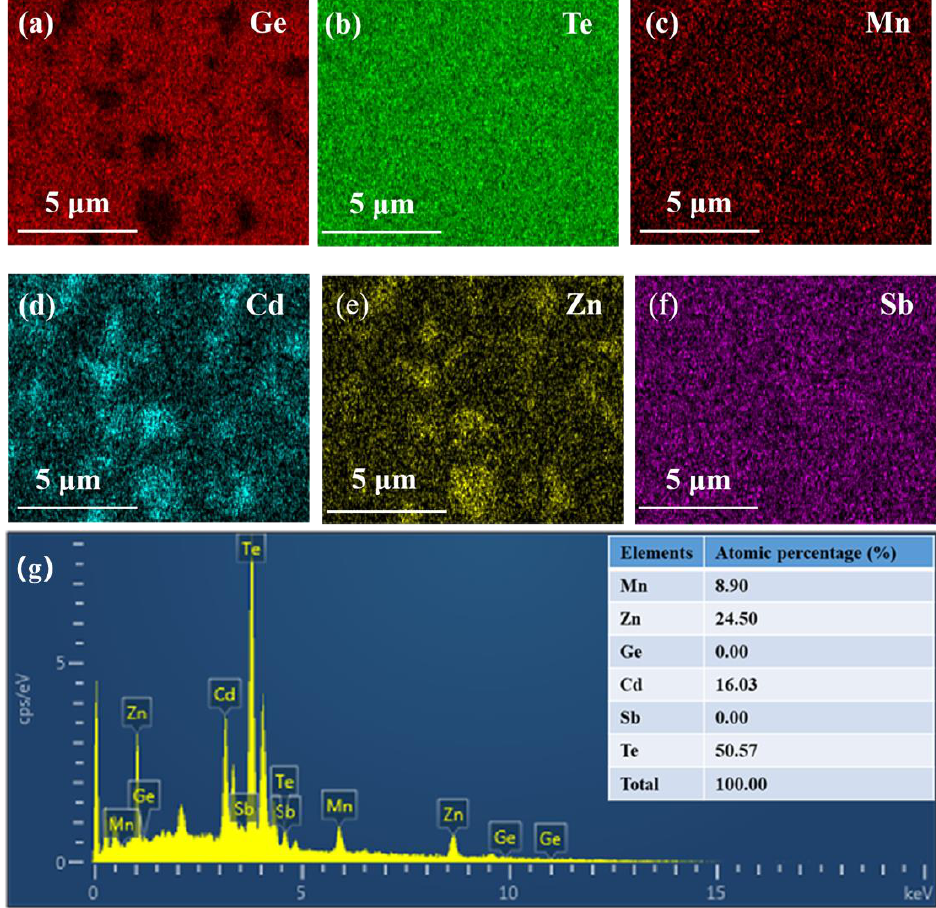
Figure 2. The scanning electron microscopy (SEM) and the X-ray energy dispersive spectrum (EDS) elemental spot scanning of the polished Ge 0.82 Sb 0.08 Te 0.90 (MnZnCdTe 3 ) 0.10 . The element mapping of ( a ) Ge, ( b ) Te, ( c ) Mn, ( d ) Cd, ( e ) Zn, ( f ) Sb, and ( g ) the X-ray energy dispersive spectrum analysis, indicating the micron-sized Zn 0.6 Cd 0.4 Te precipitations are existed.